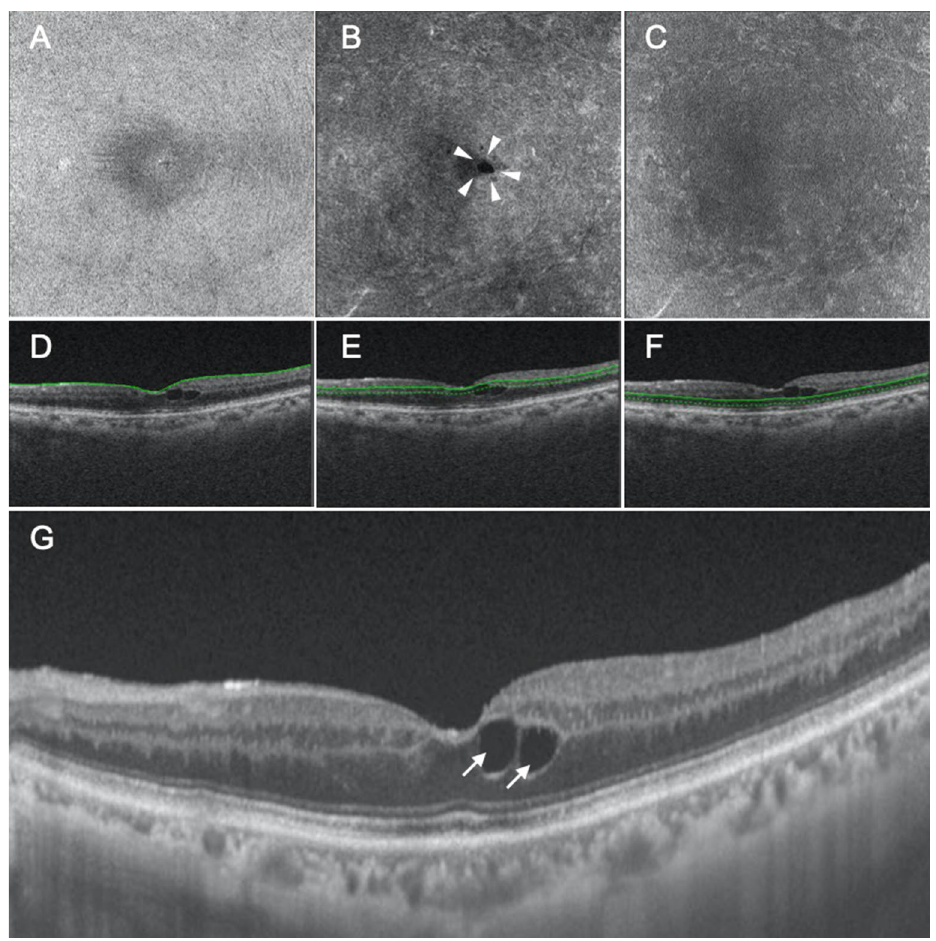
Figure 1. Representative case showing the foveal cystoid space at Segment 1/no fluid at Segment 2 type of diabetic macular edema. ( A – C ) En face images of the retinal surface ( A ), Segment 1 ( B ), and Segment 2 ( C ) are presented. The surface of the retina is smooth, and there is no epiretinal membrane ( A ). There are cystoid spaces at Segment 1, with fluid remaining within the fovea (arrowheads, B ), whereas there is no fluid at Segment 2 ( C ). ( D – F ) B-scan images and the green lines show the locations at which the en face images of the retinal surface ( D ), Segment 1 ( E ), and Segment 2 ( F ) were generated. The scan depth, indicated by the distance between the green line and green dotted line, was set to 0 μm for the en face image of the retinal surface ( D ) and 50 μm for the en face images of both Segments 1 and 2 ( E , F , respectively). ( G ) A horizontal B-scan image centered at the fovea is presented. Foveal cystoid spaces are located at Henle’s fiber layer